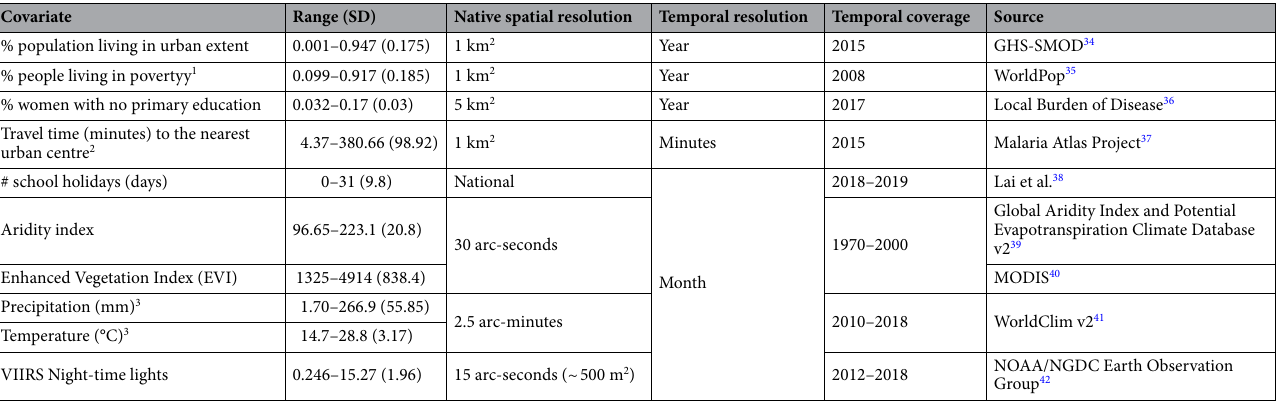
Table 1. Covariate data, sources, spatial resolution, and temporal resolution/coverage. 1 Poverty is defined as proportion of residents living in MPI-defined poverty. 2 Urban centre defined as a contiguous area with 1500 or more inhabitants per square kilometre, or a majority of built-up land cover coincident with a population centre of at least 50,000 inhabitants. 3 Available at: https:// world clim. org/ data/ month lywth.